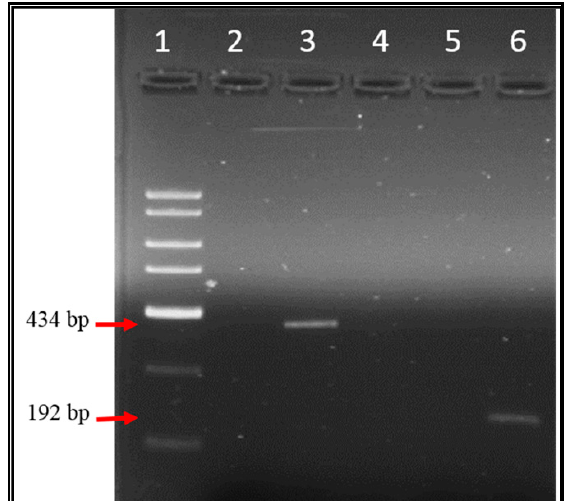
Figure 2. Agarose gel electrophoresis of enterovirus and hepatitis A virus (HAV) RT-PCR products from Tubli WPCC effluent’s sewage samples. Lane 1: 2 Kb DNA ladder, Lane 2: negative control of